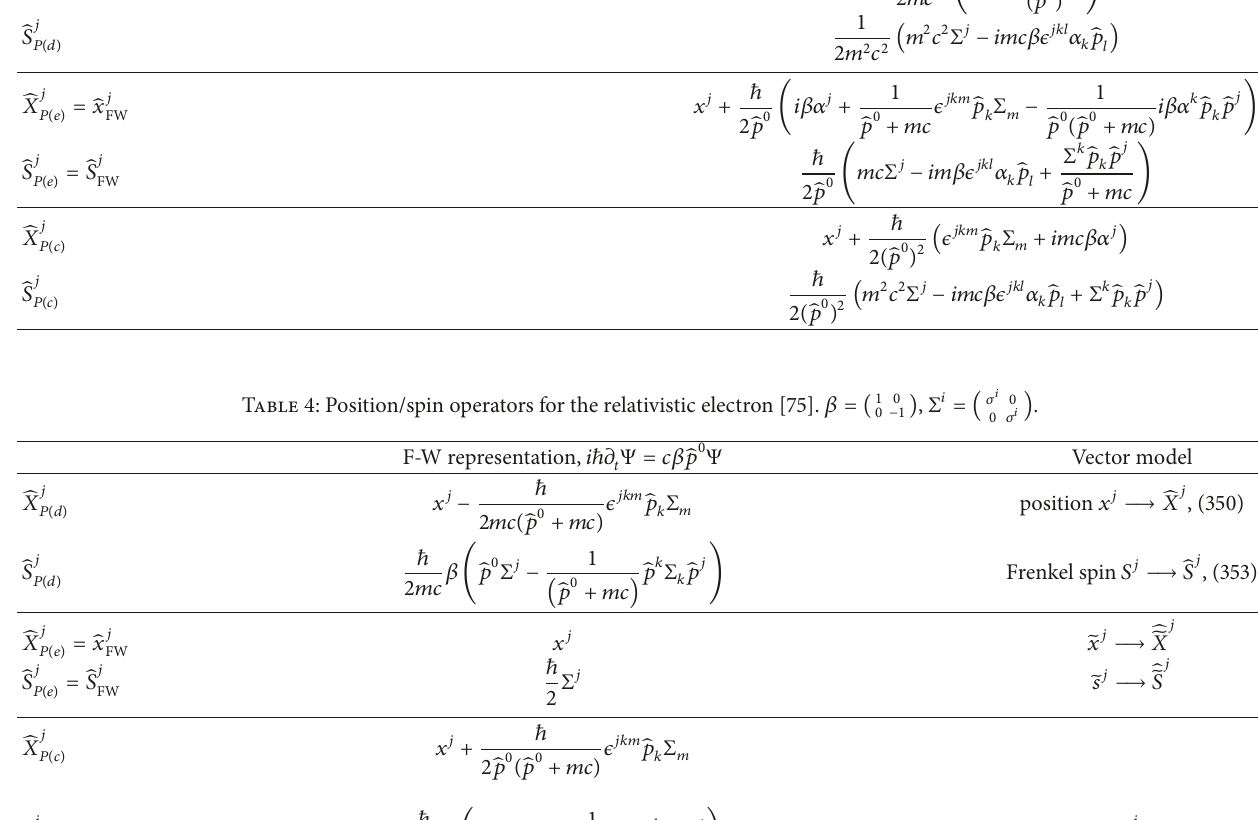
𝑖 ) , Σ 푖 = ( 휎 𝑖 0 ) . 0 휎 𝑖 휎 𝑖 0 Dirac representation, 𝑖ℏ𝜕 푡 Ψ 퐷 = 𝑐(𝛼 푖 𝑝 푖 + 𝑚𝑐𝛽)Ψ 퐷